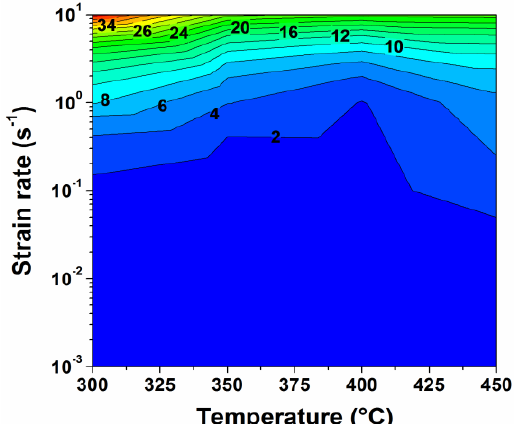
Figure 10. Maximum increase of sample temperature (Δ T tests as a function of deformation temperature and strain